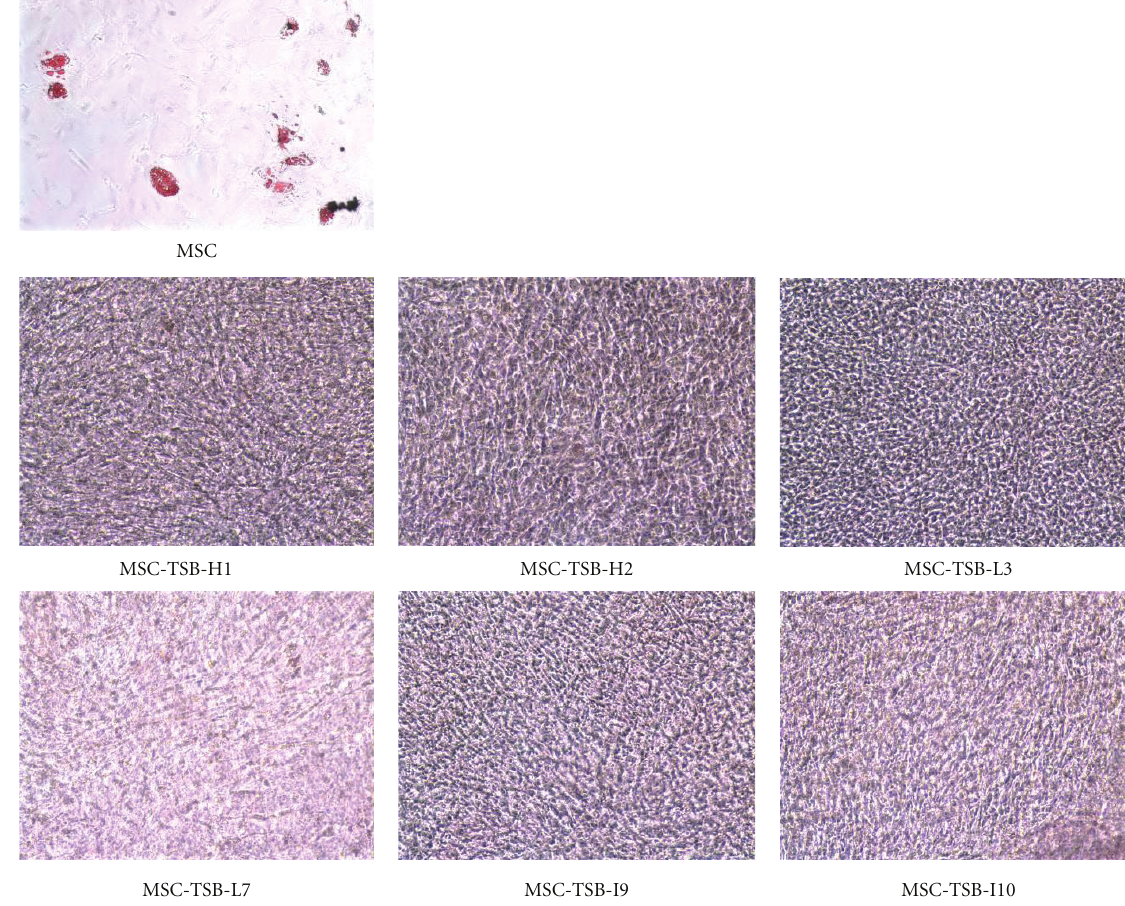
Figure 6: Adipogenic di ff erentiation is not present as determined by staining with Oil Red O in the various MSC-TSB clones after 8 weeks in di ff erentiation media. hMSC demonstrates adipogenic di ff erentiation by Oil Red O staining after 4 weeks in di ff erentiation media as a positive control (10x